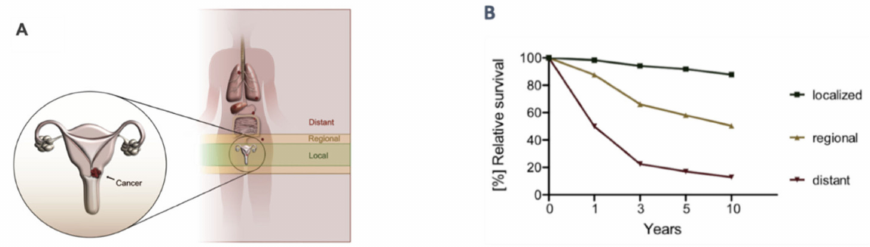
Figure 1. Overview of cervical cancer and relative survival rates in patients. ( A ) Cervical cancer can be broadly defined as local (confined to primary site), regional (spread to regional lymph nodes) or distant disease (distant metastasis). ( B ) The graph shows the relative 1-, 3-, 5- and 10-year survival of cervical cancer patients with respect to the tumor dissemination (data extracted from the SEER program (NIH)).